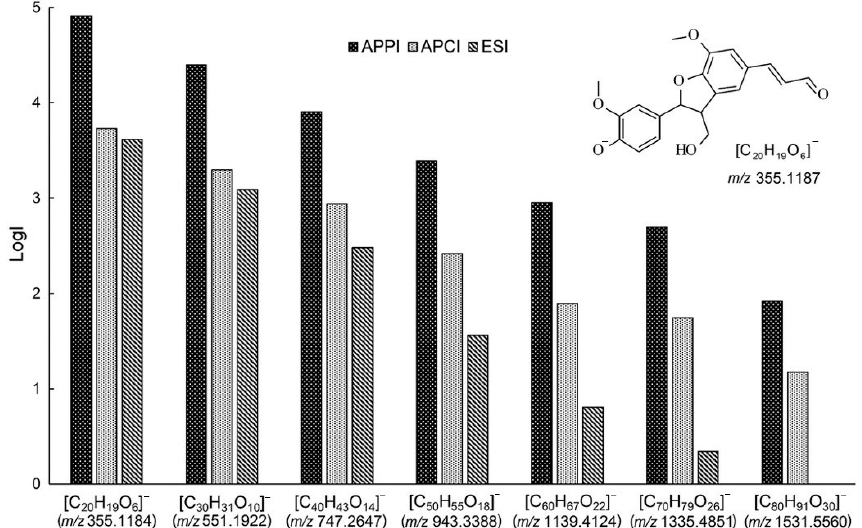
Figure 3. Comparison of the peak intensity (LogI) of lignin oligomers in the mass spectra obtained by electrospray ionization (ESI), atmospheric pressure chemical ionization (APCI) and atmospheric- pressure photoionization (APPI). Reprinted from Kosyakov et al. with permission from Wiley [26].